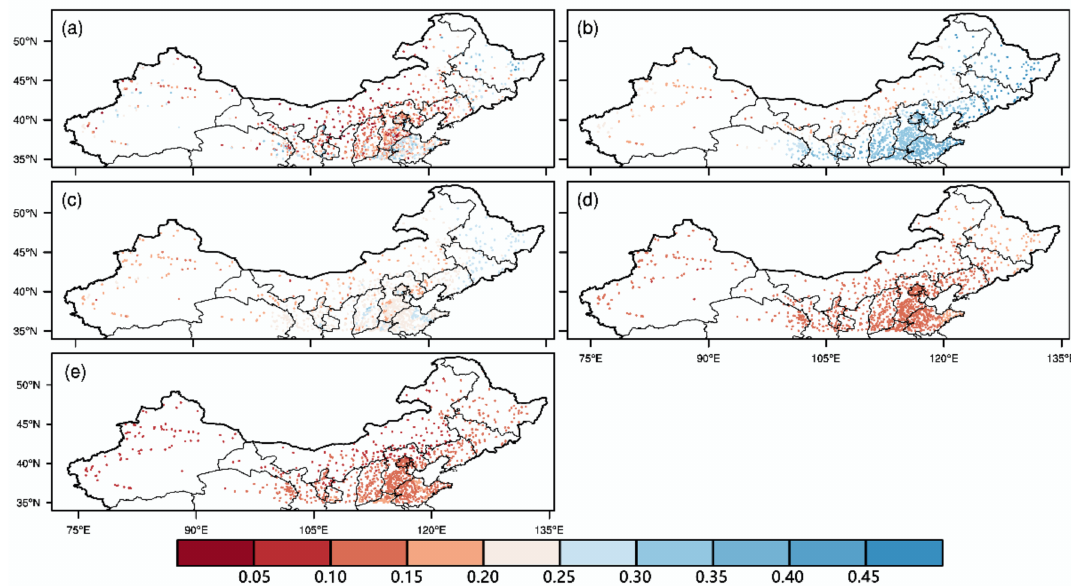
Figure 3. Soil moisture observation and spatial distribution of the median of different soil moisture products (Unit: m 3 · m − 3 ); ( a ) Observation values; ( b ) AMSR2 product; ( c ) CCI product; ( d )